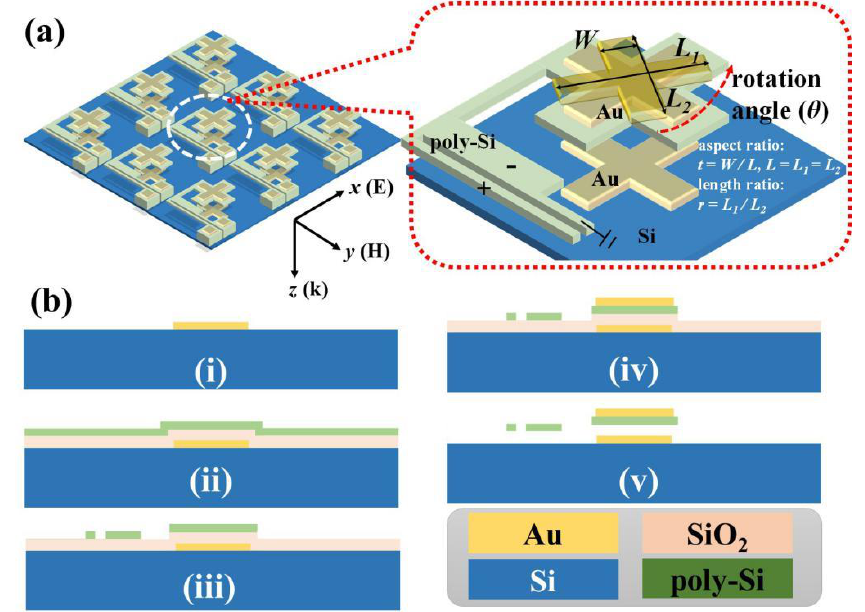
Figure 1. ( a ) Schematics drawing of electromechanically rotatable cross-shaped metamaterial (CSM) array and the corresponding denotations of geometrical parameters. ( b ) Fabrication process flow of proposed CSM device. ( b-i ) The deposition of Au thin-film with 200 nm in thickness by using lift-off process. ( b-ii ) SiO 2 and poly-Si thin-films with 500 nm and 40 nm in thicknesses, respectively, were deposited by using plasma enhanced chemical vapor deposition (PECVD) process. ( b-iii ) Poly-Si thin-film was patterned by using reactive ion etching (RIE) process. ( b-iv ) The deposition of Au thin-film with 200 nm in thickness by using lift-off process. ( b-v ) The nanostructures were released by using vapor HF.